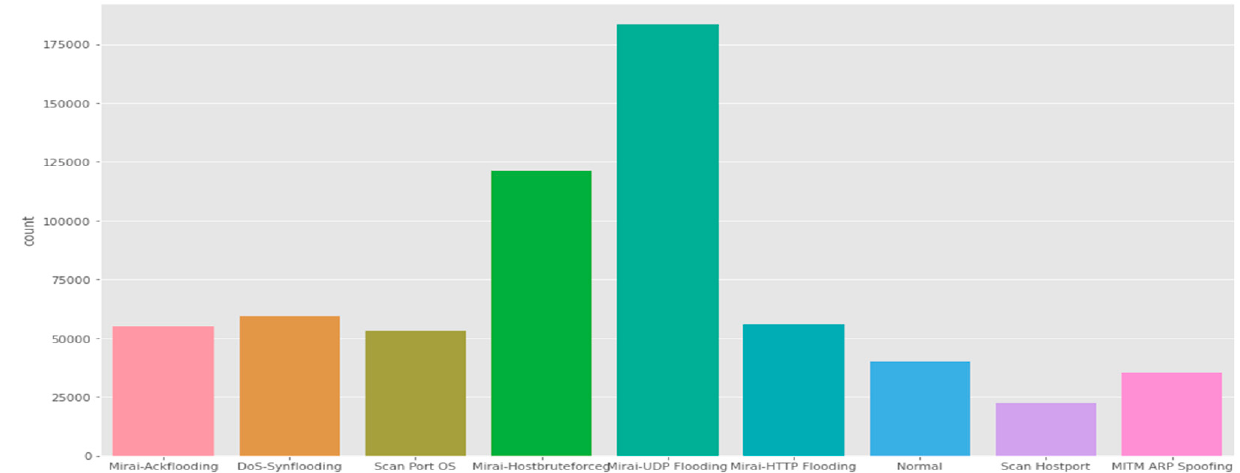
Figure 9. The main categories of attacks are found in the IoTID20 dataset.